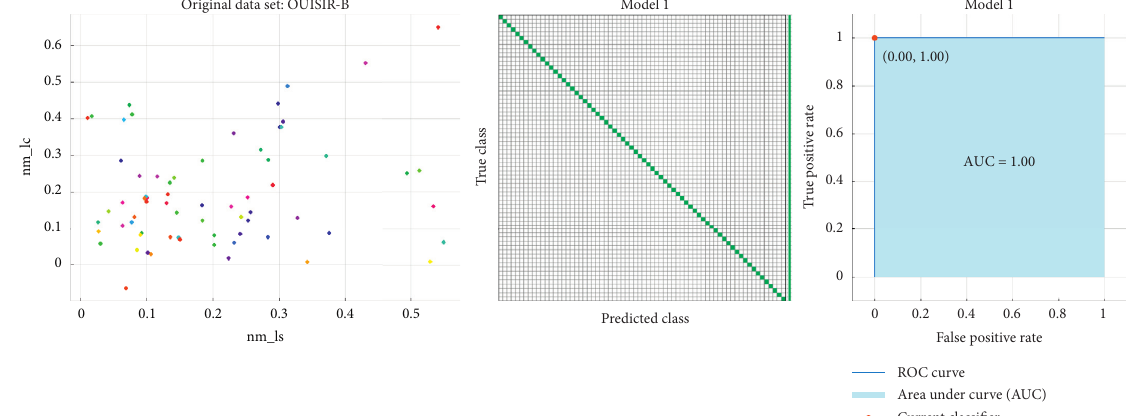
Figure 12: Gait recognition with Cross-Correlation Score, confusion matrix, and ROC curve of